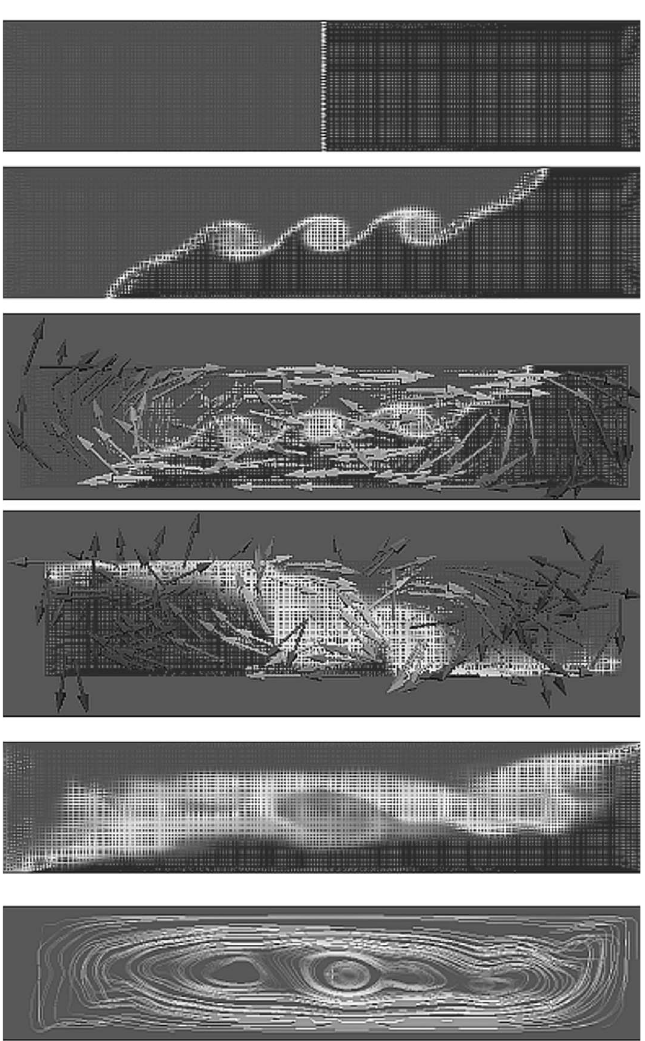
Figure 8. Mixing two fluids of various diffusion coefficients – OpenFoam